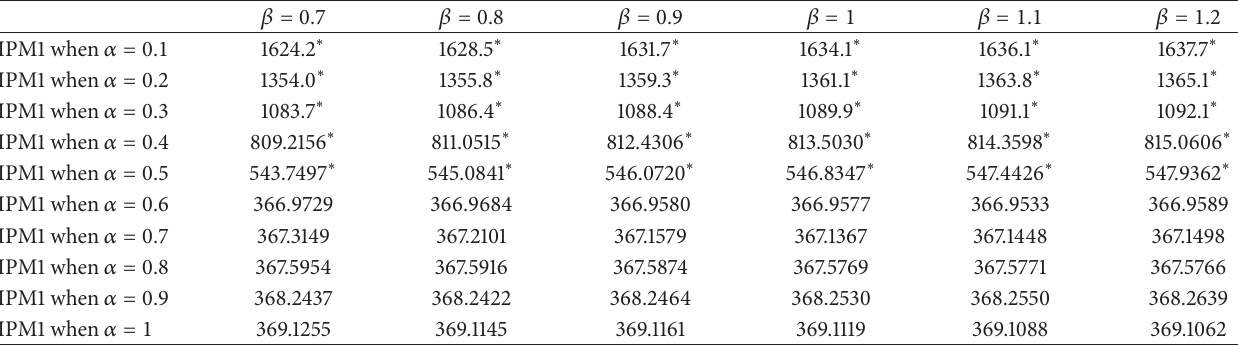
Table 3: Prediction errors of the new improved parsimonious multivariate Markov chain model with the original convergence condition in